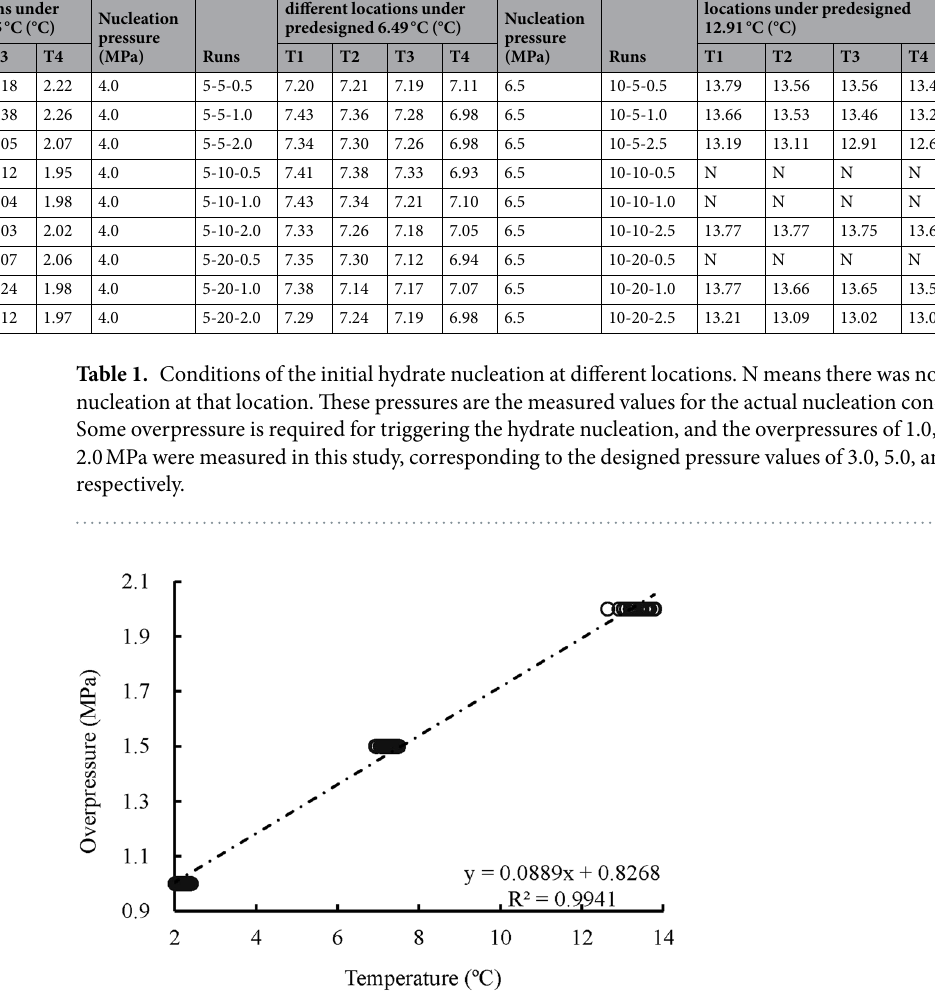
Figure 2. Statistical relationship between the overpressure and temperature during hydrate nucleation. The target pressures of 3, 5, and 10 MPa correspond to the designed temperatures of 1.45, 6.49, and 12.91 °C,